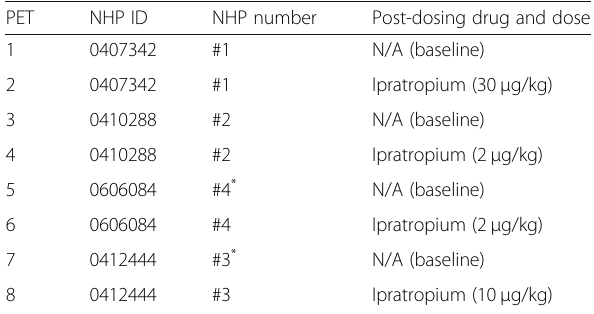
Table 1 PET measurements in panel 1. Drug delivery via